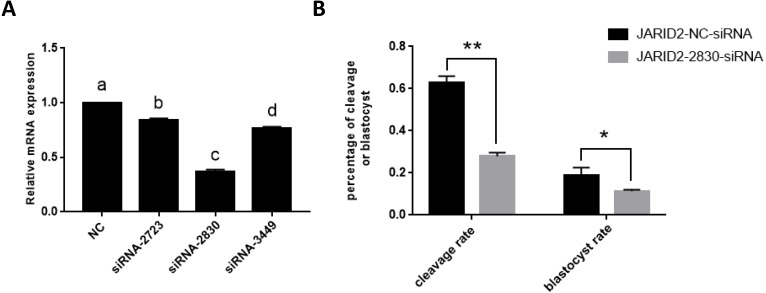
The influence of JARID2 siRNA interference on early embryonic development.(A) The silencing effects of siRNA targeting different loci on JARID2 in bovine cumulus cell. Among the three siRNAs, siRNA-2830 has the highest silencing efficiency. After microinjection, the expression of JARID2 is significantly lower in the siRNA-2830-injected group by about 65% than the negative control group (p < 0.05); therefore, siRNA-2830 is suitable for subsequent RNA interference. (B) The effect of JARID2 silencing through microinjection of siRNA-2830 on early embryonic development. The cleavage rate are extremely significantly lower (p < 0.01) and blastocyst rate are significantly lower (p < 0.05) in the siRNA-treated group than in the negative control group. Data are presented as the mean ± SD derived from triplicate transfectants of three independent experiments. Different superscripts (a and b) denote a statistically significant difference. ∗ denotes a statistically significant difference (p < 0.05), and ∗∗ denotes an extremely significant difference (p < 0.01).